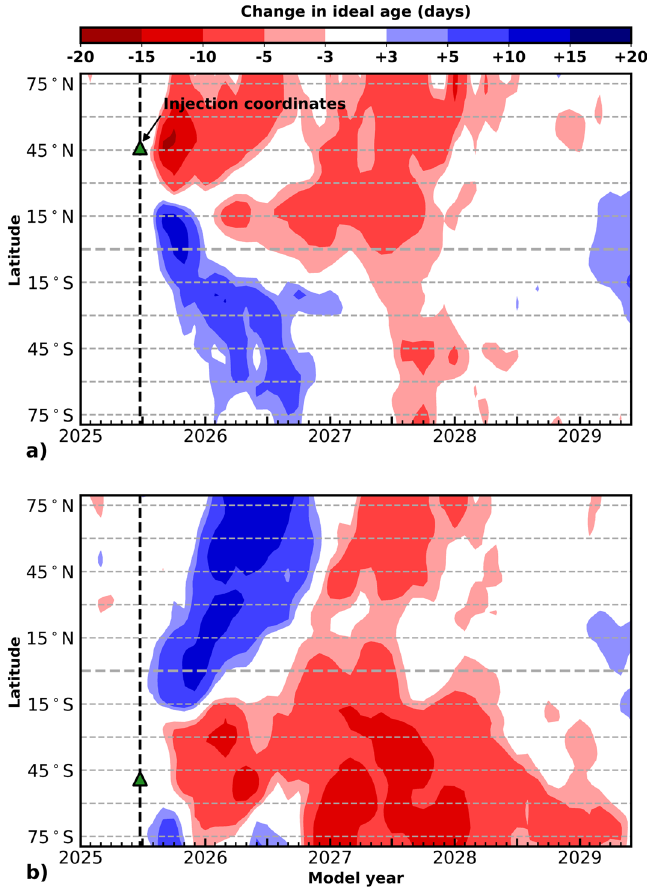
Figure 5. Ideal age of air response to 5 Tg SO 2 injection (SSP3-70 July 25, 2025) as a function of latitude and time, where ideal age is a modeled variable that describes the age of air relative to its transport from the surface. In both panels, computed metrics reflect the difference between the eruption perturbation ensemble and the control ensemble with a 4-year time-horizon, and the latitude and date of SO 2 injection is indicated by a green ◦ ◦ triangle and a dashed line. The latitudes of eruption are 42 N and 50 S for panels ( a ) and ( b ),